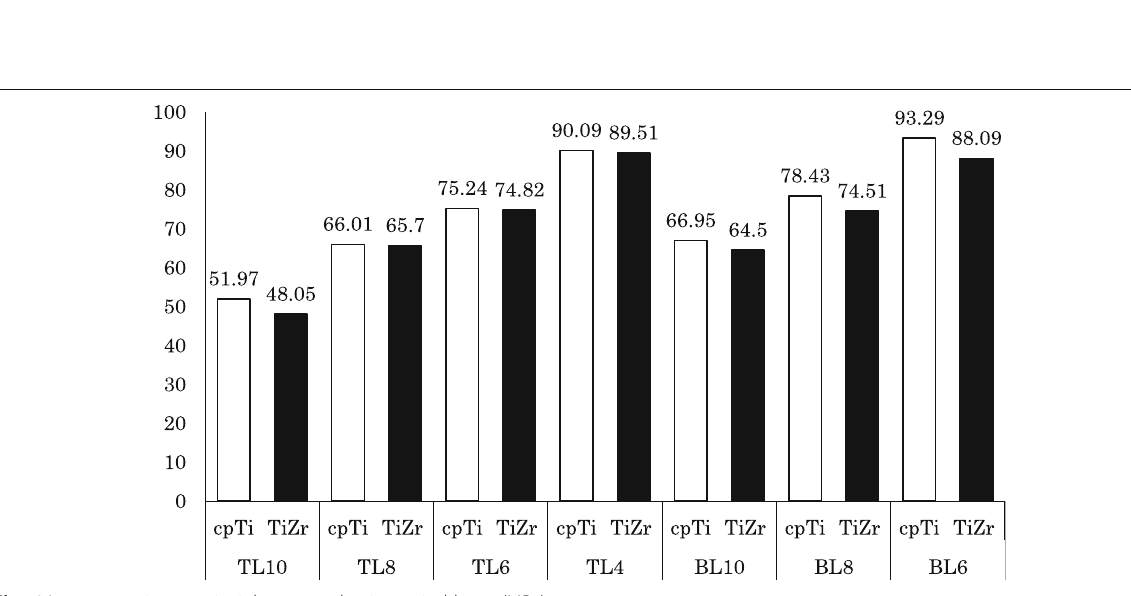
Fig. 6 Largest maximum principle stress value in cortical bone